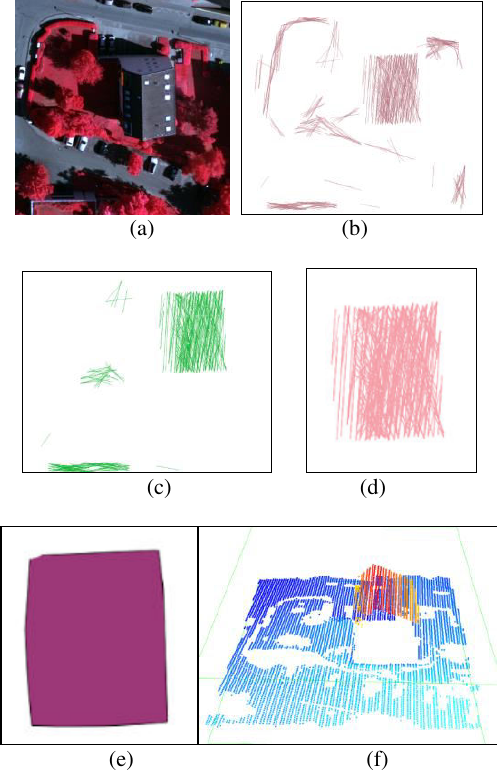
Figure 13. (a) Satellite Area of study (b) Segment Extraction (c) Remaining Segments after rule based Height thresholding (d) Remaining Segments after Rule based filtering (e) Final local convex hull of the potential building (f) Gabled roof building segmented from the input LiDAR data shown in